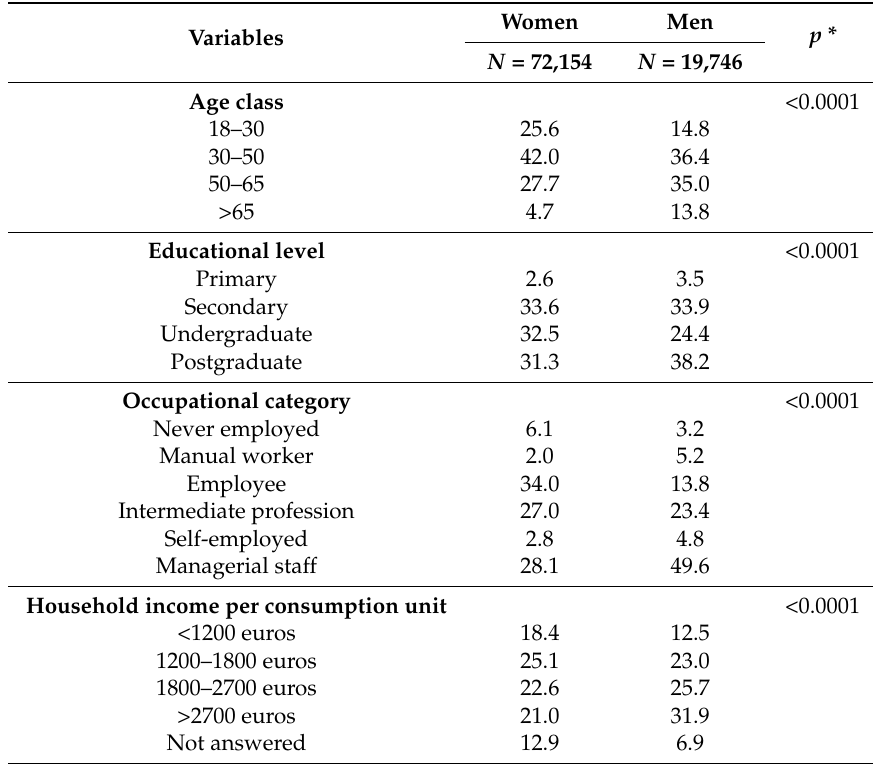
Table 1. Socioeconomic and socioeconomic characteristics of the sample ( N =